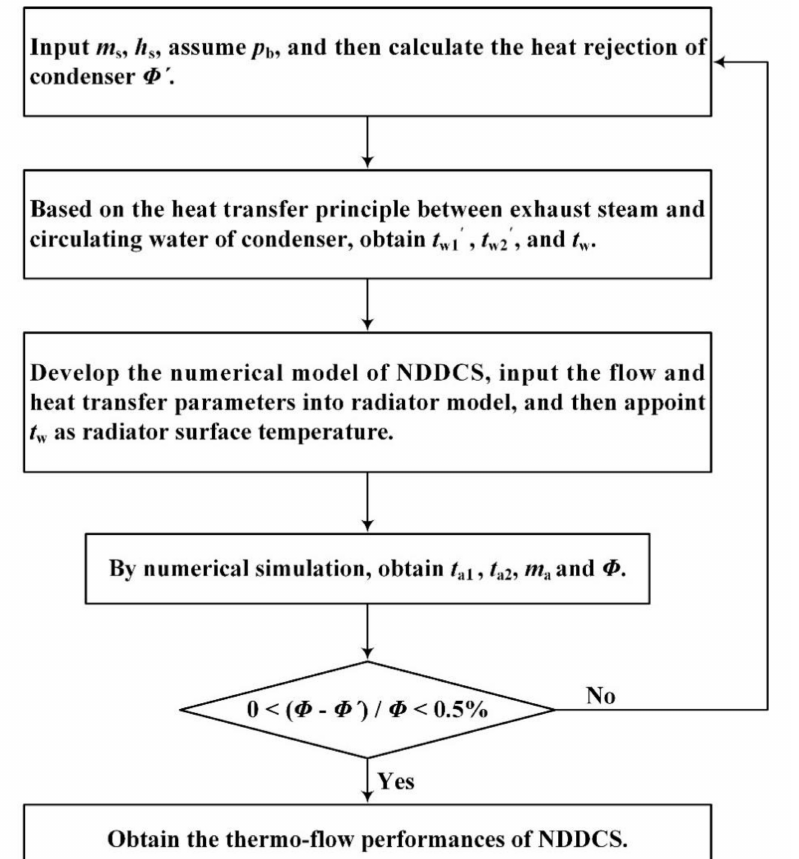
Figure 4. Numerical iteration process for various steel-truss cooling